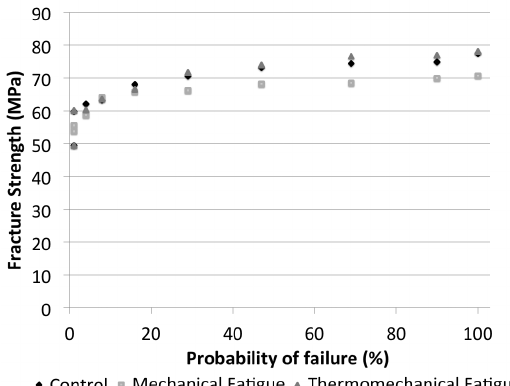
Figure 6. The fracture strength of zirconia implants evaluated by Weibull distribution.